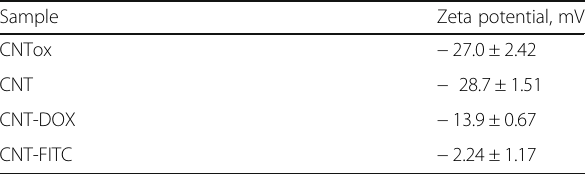
Table 1 Zeta potential of CNT samples at dilution 1:10